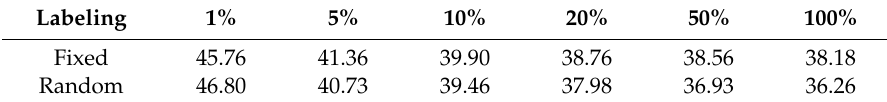
Table 5. FD004 RMSE Semi-supervised feature learning with semi-supervised regression.